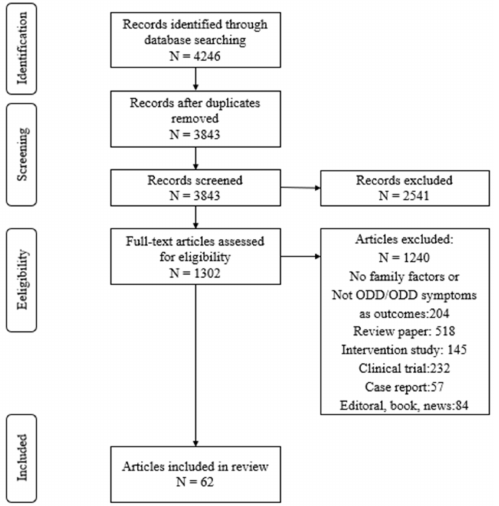
Figure 1. Flow diagram of study